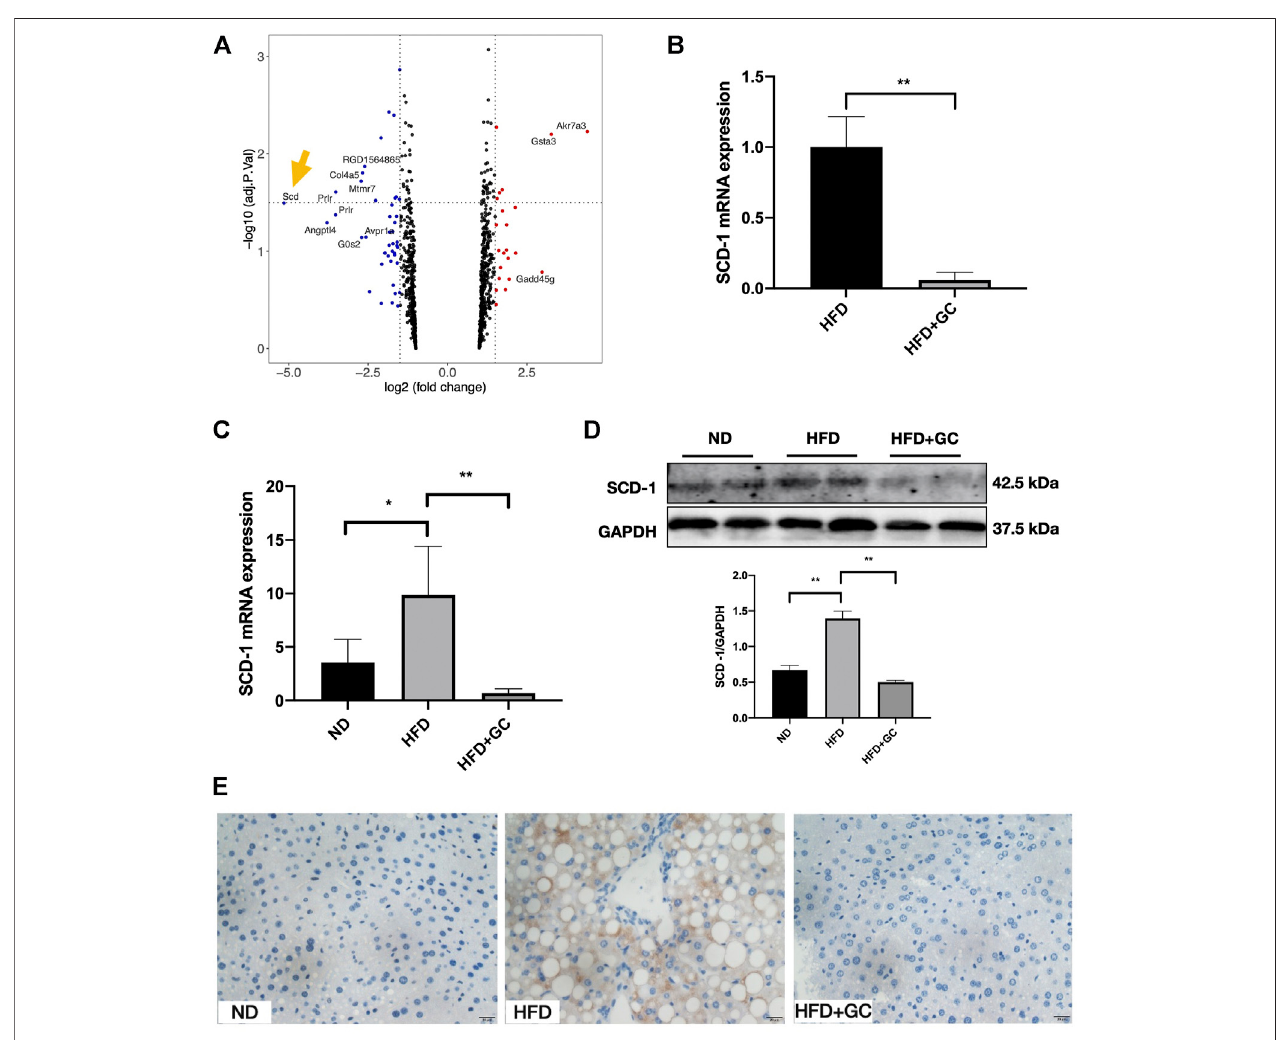
FIGURE 4 | SCD-1 is the most signi fi cant differential gene highlighted in microarray and signi fi cantly down-regulated by the GC combination. (A) Volcano Plot for differential gene expression between HFD and HFD + GC group in the liver of rats ( n (cid:1) 3), logFC < 1 was deleted during the analysis. SCD-1 mRNA expression in rat (B) andmice (C) livertissueswasveri fi edbyreal-timePCRanalysis.SCD-1protein expressioninmiceliverwasdetected byimmunoblotting (D) andimmunohistochemistry (E) (Brown area, 400 times of magni fi cation), and the relative expression levels of proteins were corrected by GAPDH. * p < 0.05, ** p <